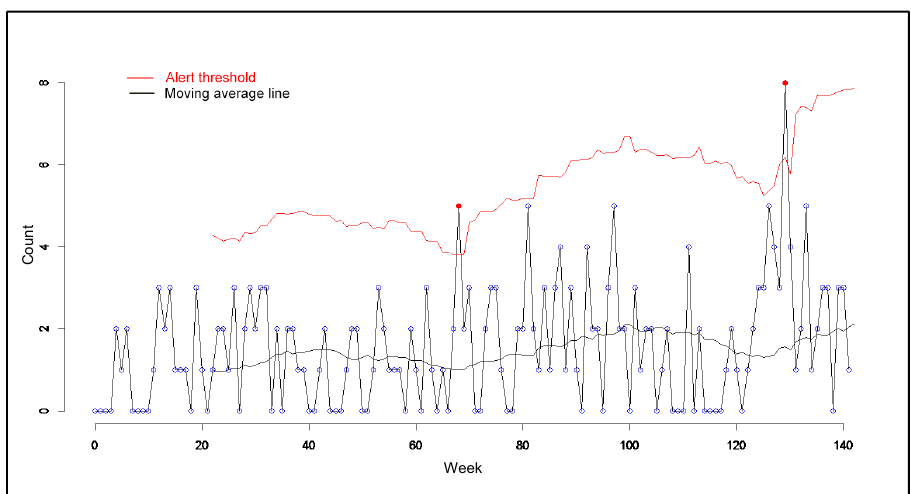
Figure 2. Salmonella counts by week with alert thresholds, Insight data base.